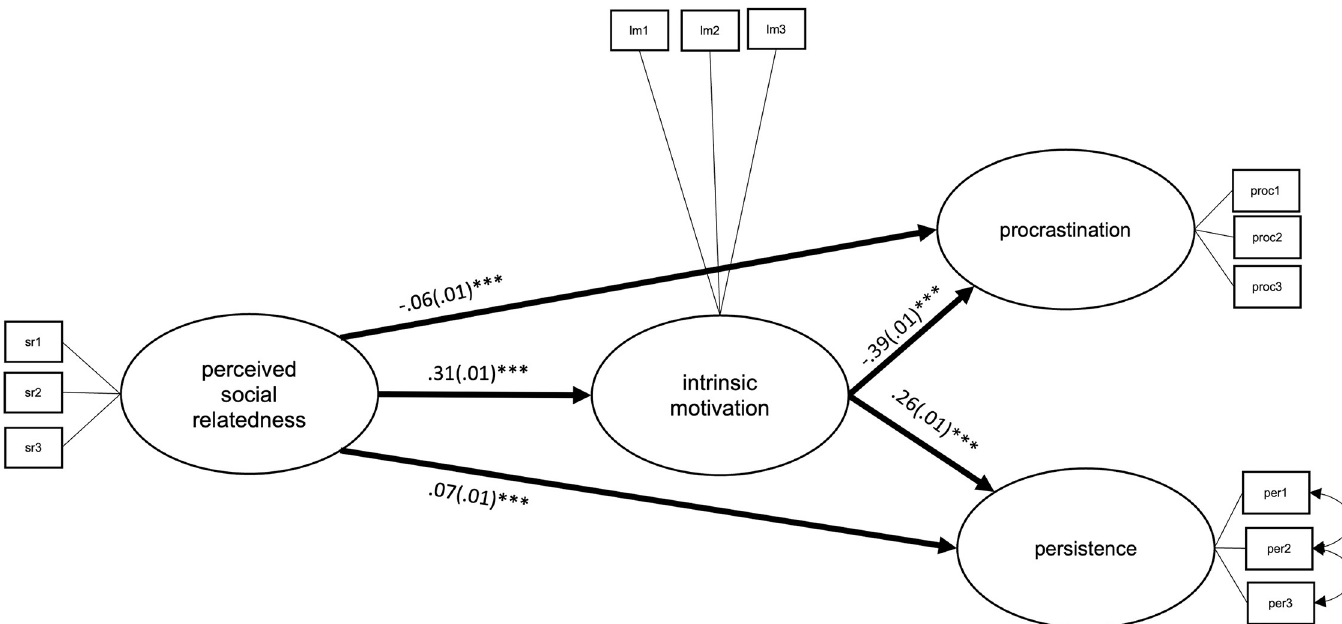
Fig 9. Latent structural path model of the direct effects between perceived social relatedness, intrinsic motivation, procrastination, and persistence, with average coefficients across all countries. ��� p = < .001.